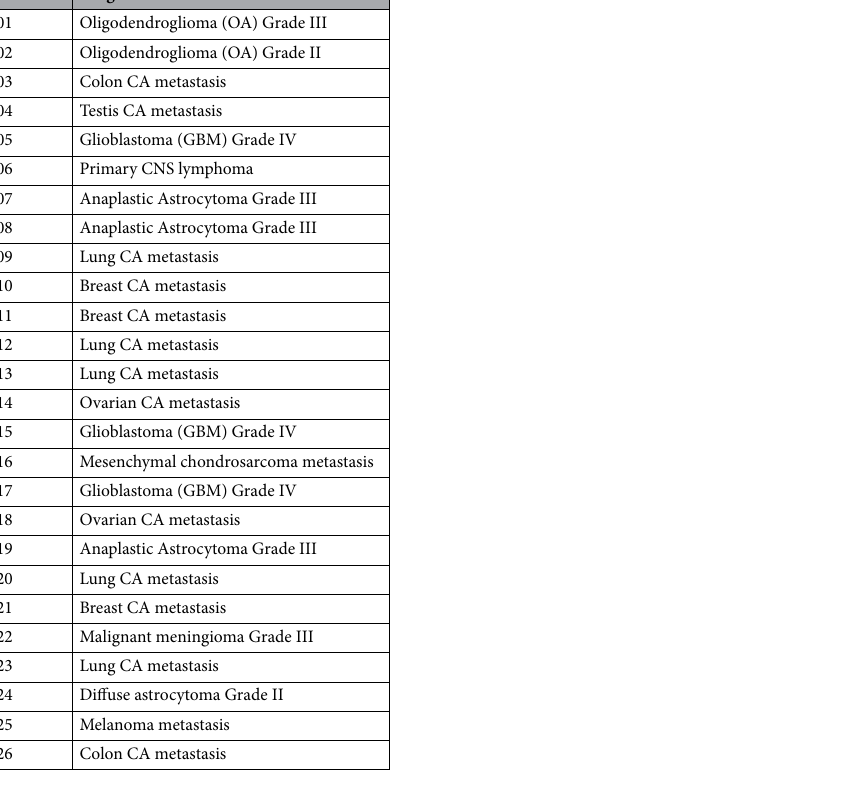
Table 1. Patient list for organoid culture in